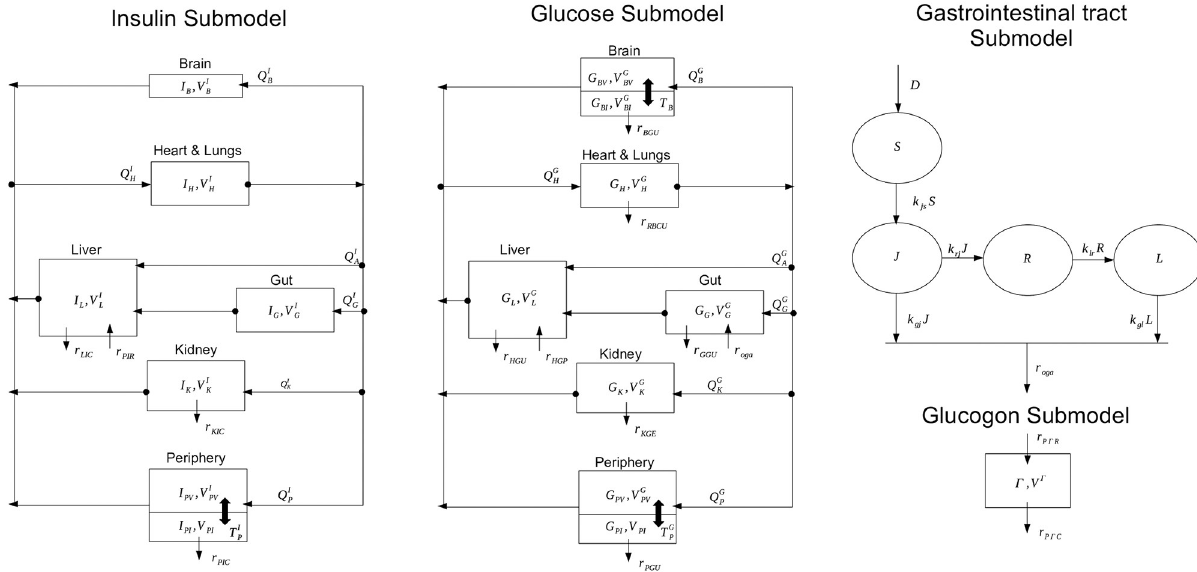
Fig 1. Schematic representation of the Sorensen model (block diagrams). With arrows representing flows between compartments, and block diagram of the gastric intestinal tract. Output from the gastric intestinal model represents the input into the G G compartment; arrows represent mass transfer.